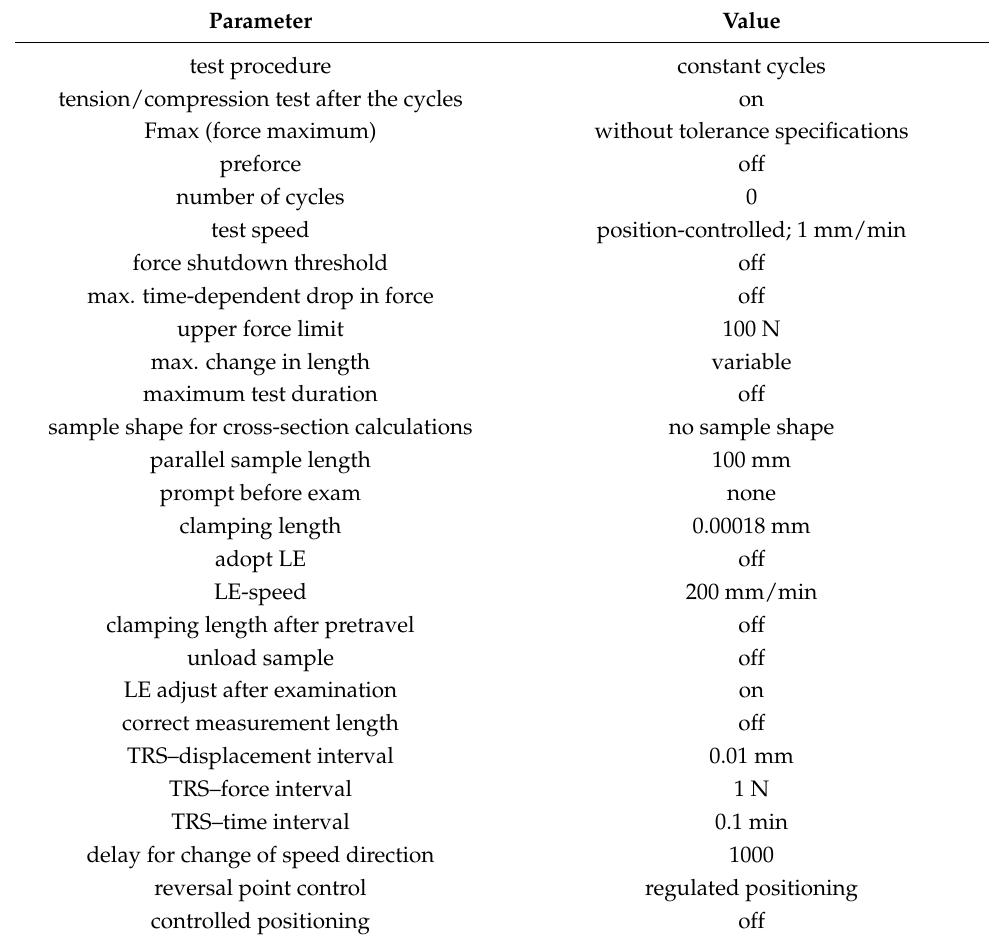
Table A1. Detailed machine settings for the Zwick